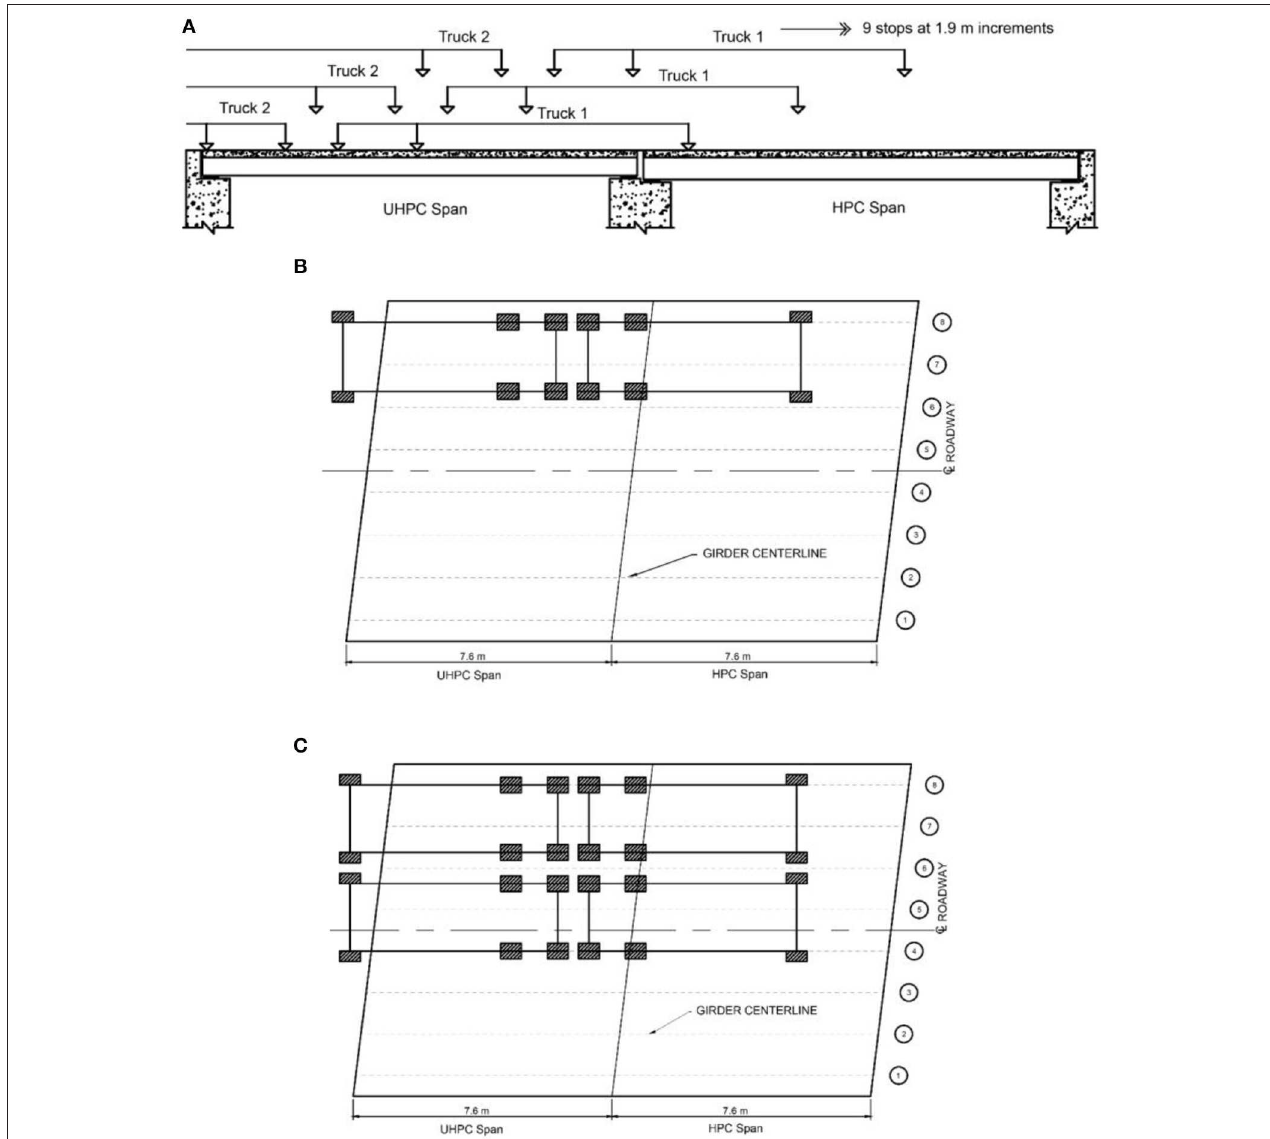
FIGURE 9 | Path configurations (A) bridge profile with trucks, (B) top view of single truck back-to-back path, (C) top view of double truck back-to-back path.